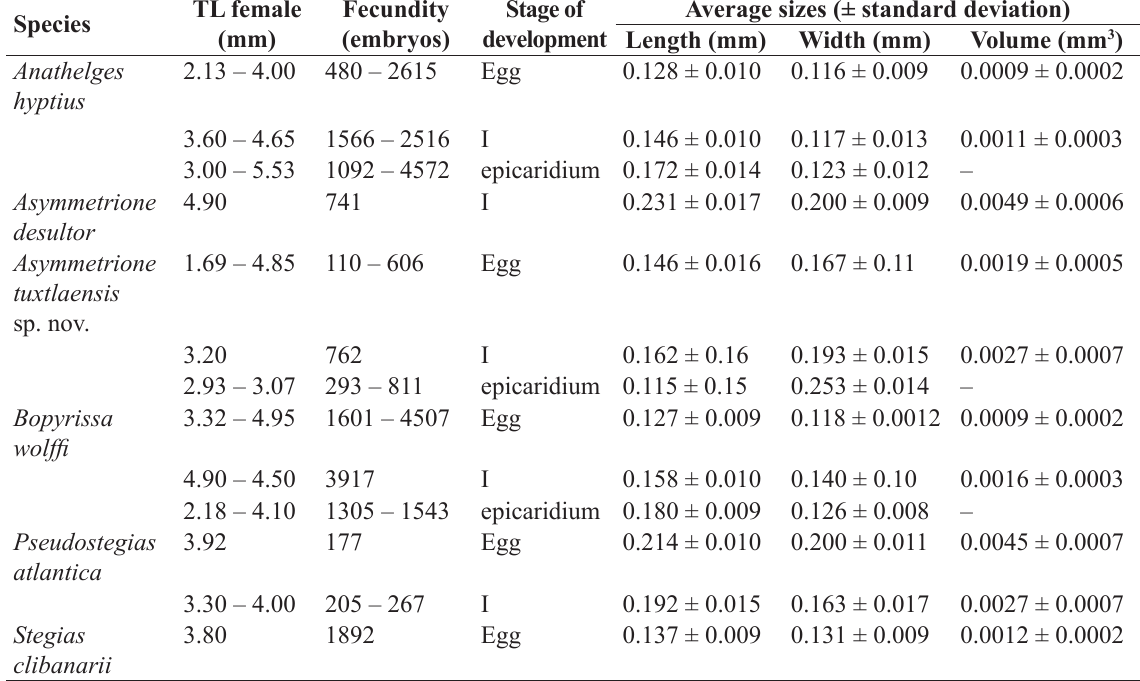
Table 1. Some reproductive traits of the bopyrid isopods that parasitize hermit crabs at SW Atlantic coasts of